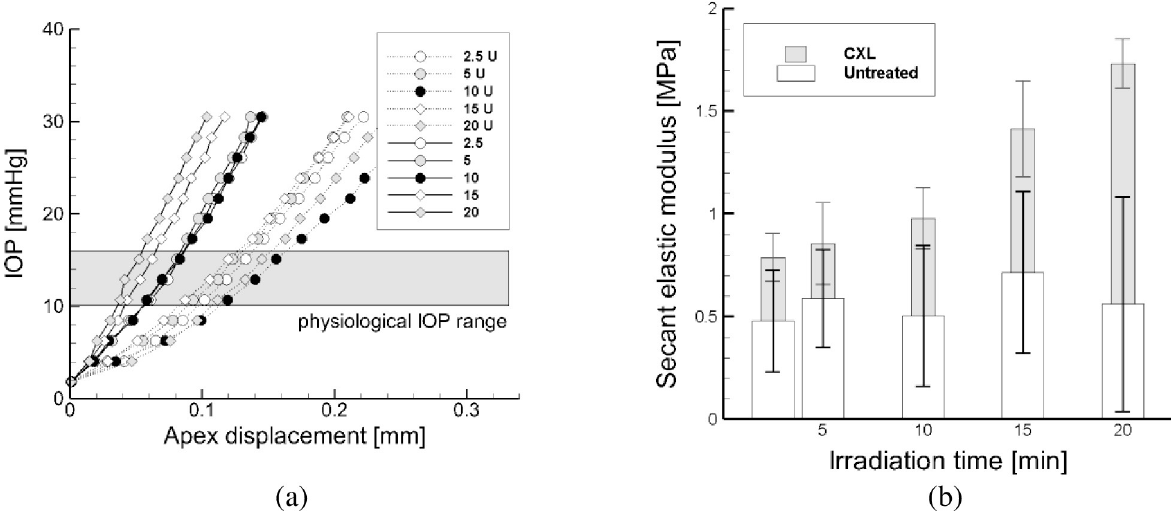
Fig 7. (a) Average pressure versus apex displacement curves. Comparison between the average untreated corneas (dotted lines) and the post CXL ones (solid lines), revealing a generalized stiffening. Corneas treated with shorter irradiation time protocol still show a change of stiffening around the physiological IOP, unlike the ones treated with longer irradiation time protocol, which show a rather linear behavior. Interestingly, in the treated corneas the slope at 30 mmHg is practically the same. (b) Average untreated E b and post-CXL E a cornea equivalent secant elastic modulus as obtained from the experiments.